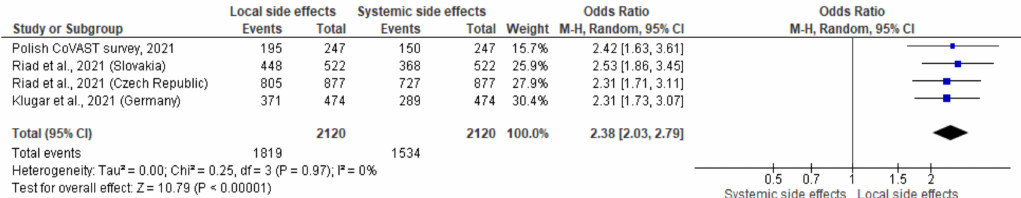
Figure 4. Forest plot of pooled analyses of total local and systemic post-vaccination adverse events in four European countries, participants of CoVAST project.